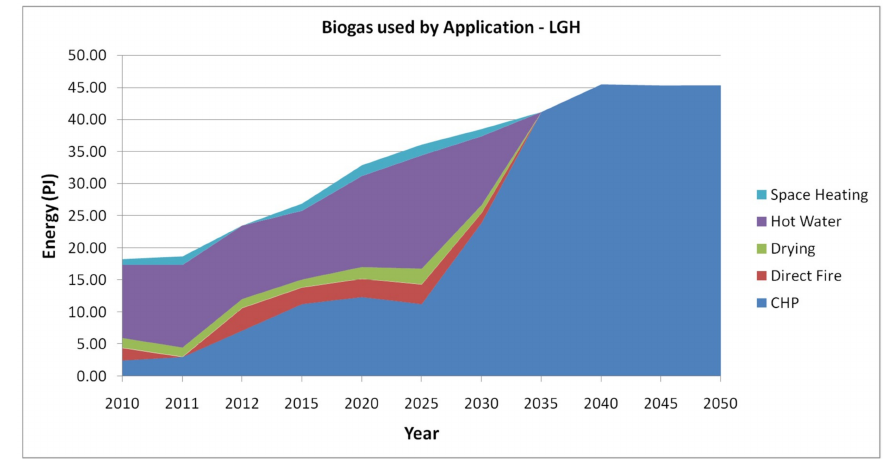
Figure 9. End-Use of biogas generated from anaerobic digesters in the LGH case. (Note that legends and colours in Figure 9 are aligned in sequential order for ease of